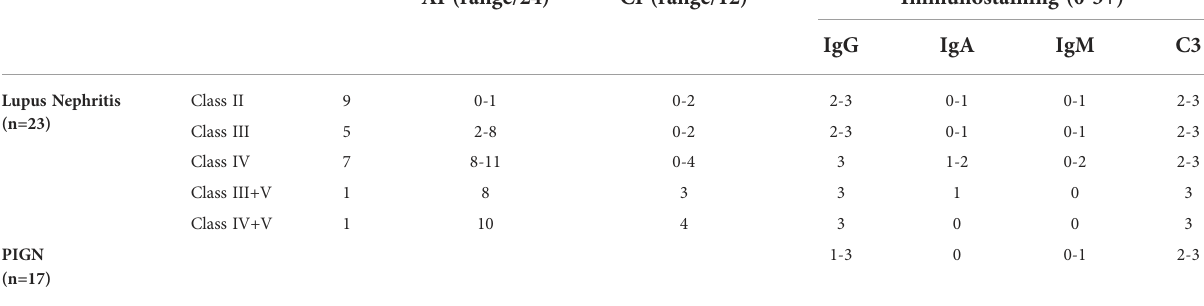
TABLE 2 Summary of the histopathologic and immunohistochemical fi ndings of the 40 studied cases.